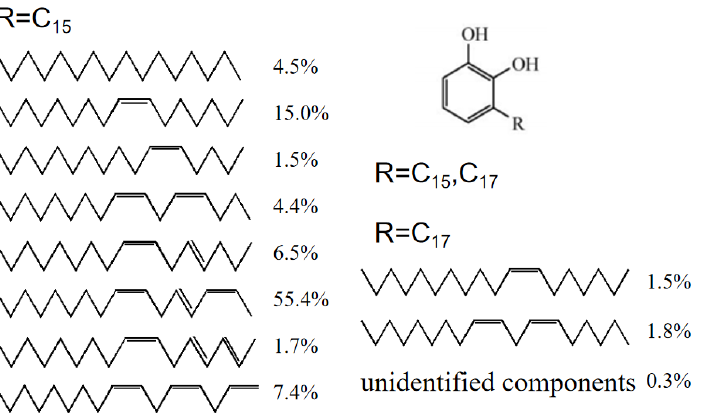
Figure 1. Structure and composition of urushiol.